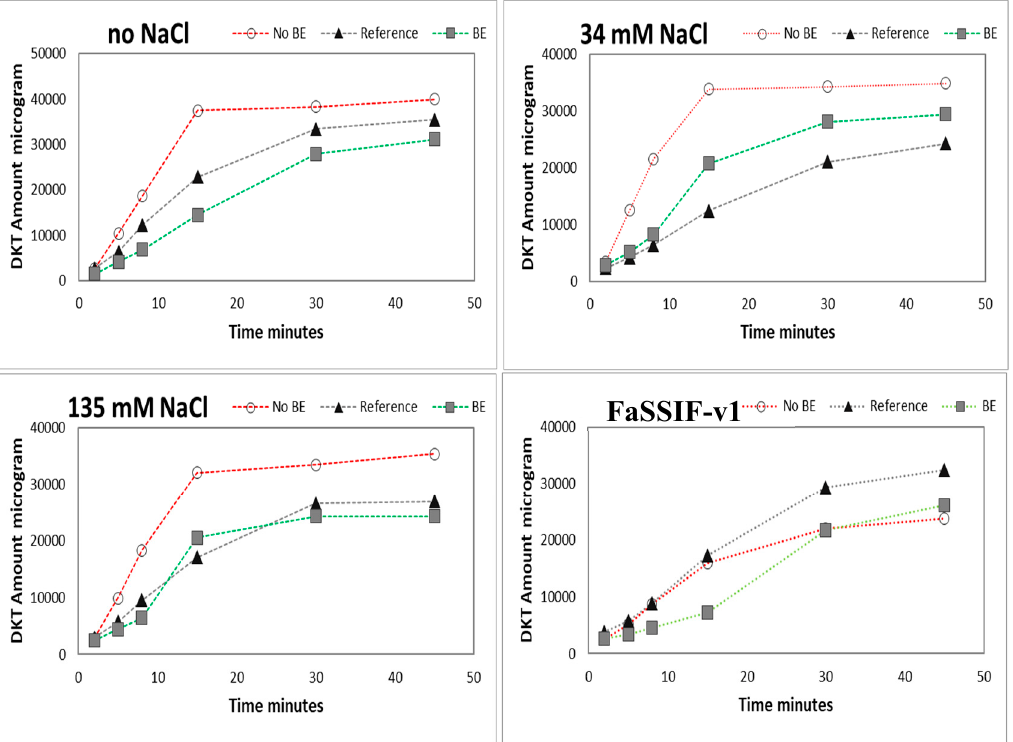
Figure 6. Amounts of DKT in micrograms dissolved in USP-2 apparatus (500 mL; 50 rpm) in acidic media (HCl 0.01M pH = 2) at different levels of NaCl content and in FaSSIF-v1 media. Data are presented as means ( n = 3).